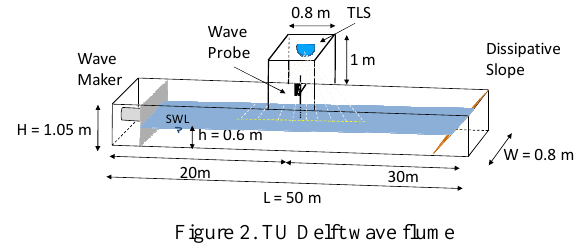
Figure 2. TU Delft wave